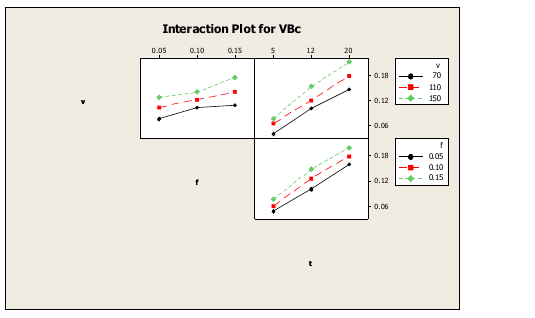
Fig.4. Interaction plot of flank wear (VBc) Fig. 5. Normal probability plot of the residuals